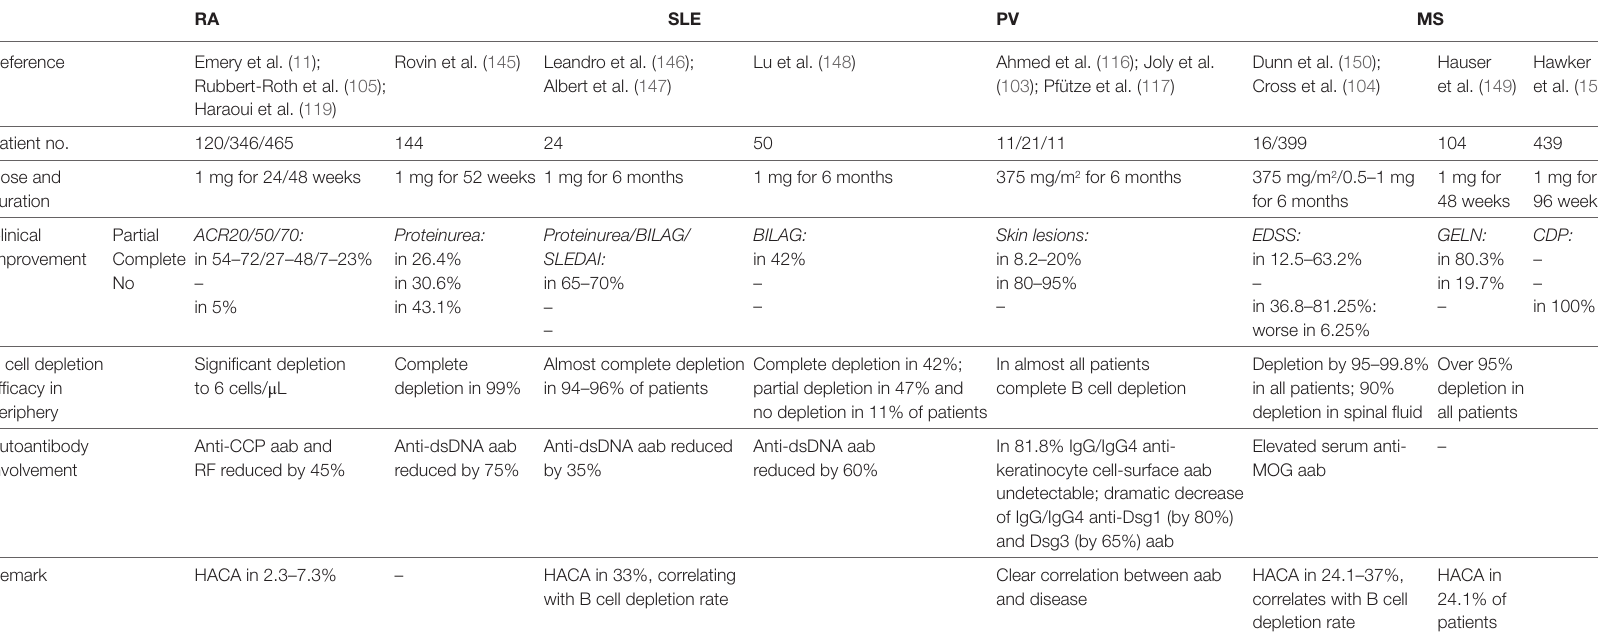
TABLe 1 | Efficacy of RTX treatment